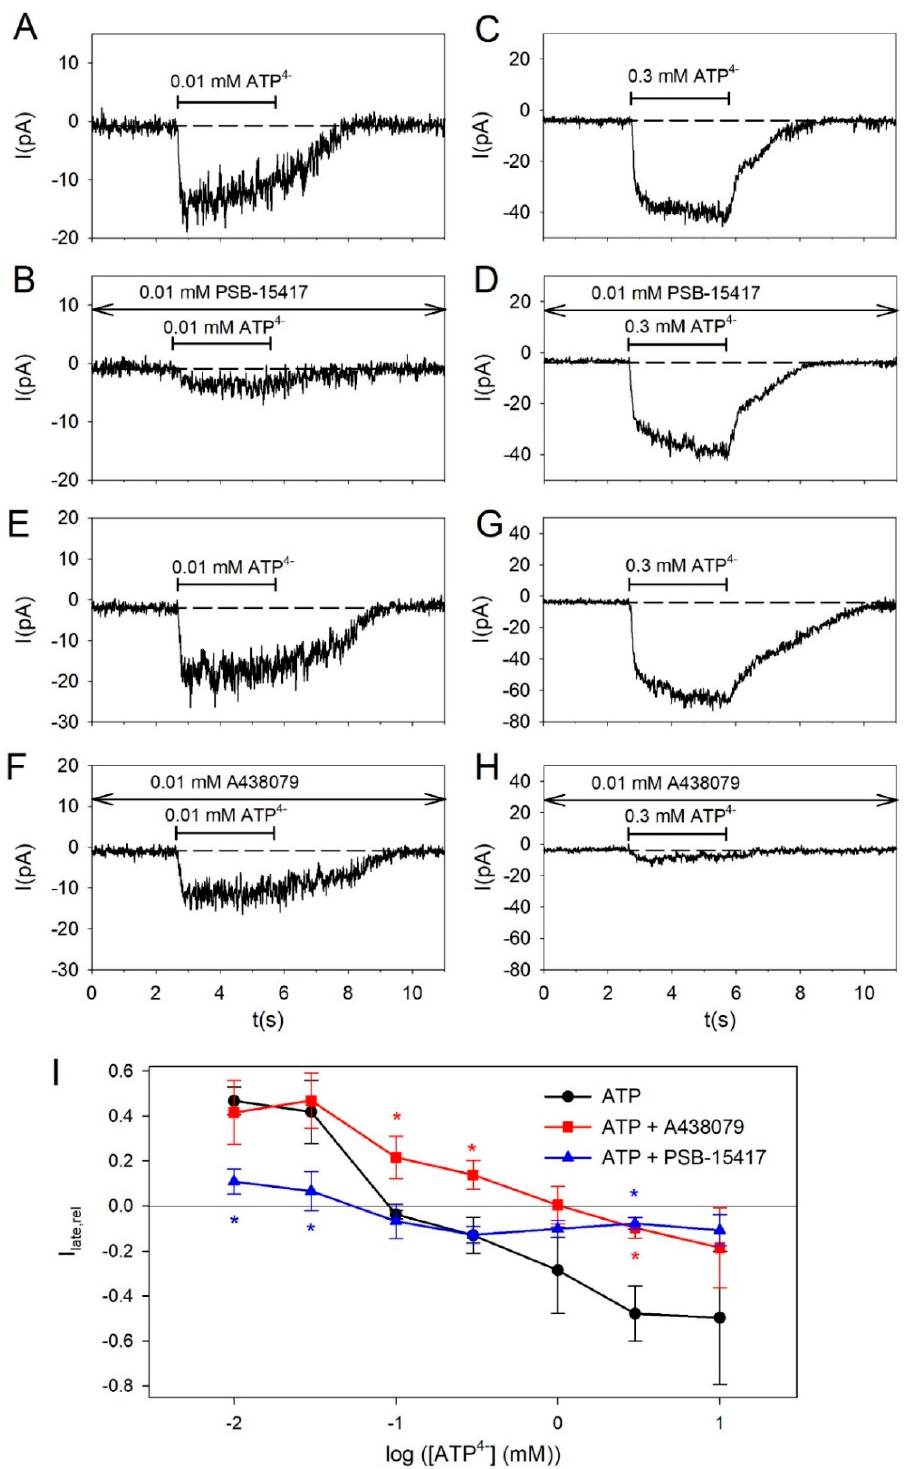
Figure 2. Concentration-dependence of kinetics of ATP-induced currents. ( A – H ) Representative current traces elicited by 0.01 or 0.3 mM ATP 4 − without and with the P2X4R blocker PSB-15417 and the P2X7R blocker A438079 as indicated. ( I ) Relative current amplitudes of the late current I late,rel were calculated according to Equation (1). The curves show the concentration dependence on ATP 4 − in the absence and presence of 10 µM PSB-15417 or 10 µM A438079 as indicated. Means ± SEM of 6–227 cells. Significant differences from the ATP 4- alone curve are marked by asterisks (blue: PSB-15417, red: A438079).